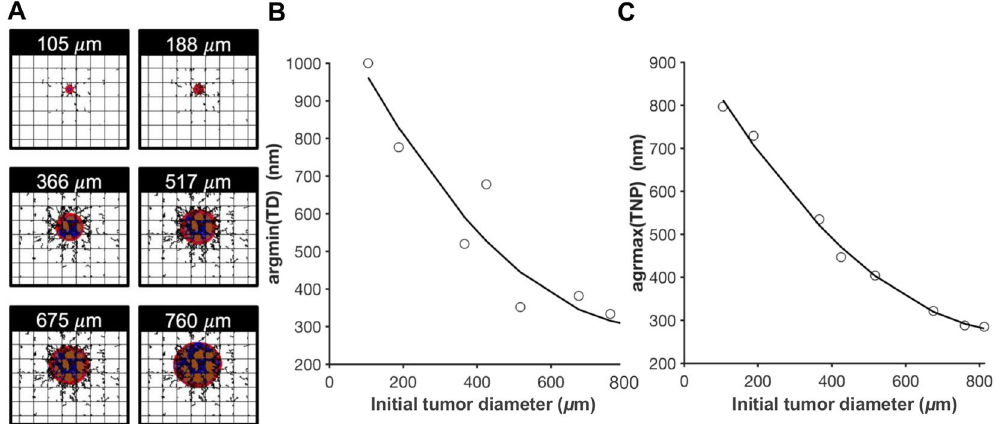
Figure 1. Optimizing nanoparticle designs for tumors of different sizes. ( A ) Tumors of different sizes at which the treatment starts. Change in optimal nanoparticle diameters that ( B ) minimizes tumor size after one day of treatment and ( C ) maximizes percent accumulation of nanoparticles in tumor tissue as a function of tumor size at start of treatment. Black lines represent the second order polynomial fit obtained by minimizing the least linear square. Red: proliferating tumor tissue; blue: hypoxic tissue; brown: necrotic tissue. Orthogonal grid represents pre-existing capillary network surrounding the growing tumor. Irregular lines simulate capillary growth in response to a net balance of pro-angiogenic factors released by hypoxic tumor tissue. Tumor diameter at start of treatment ( μ m)